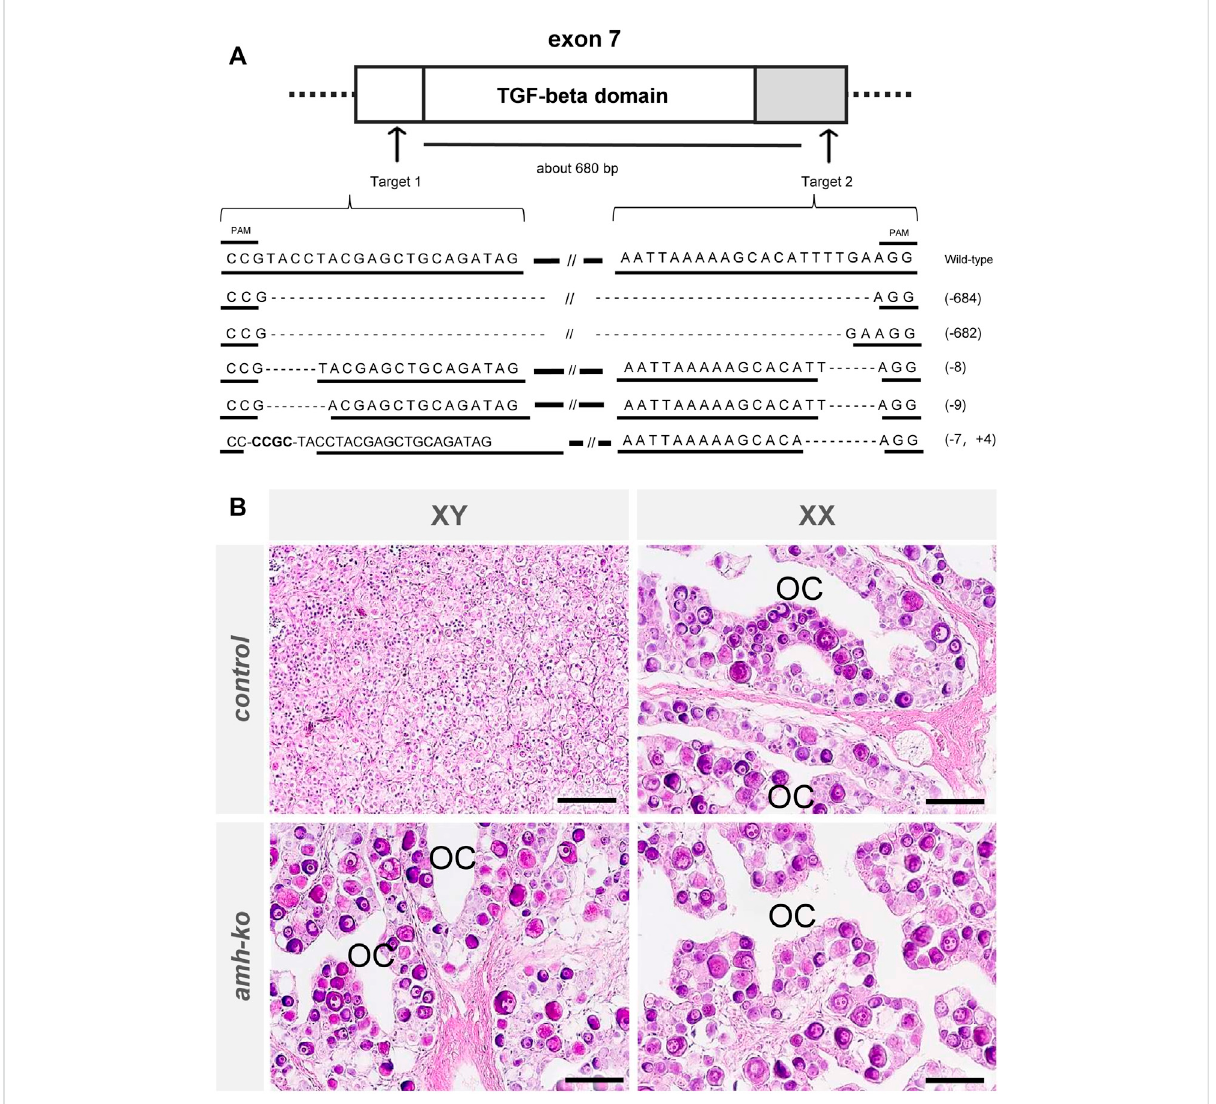
FIGURE 4 Production of amh mutant Japanese fl ounder using CRISPR/Cas9 system. (A) Schematic positions of crRNAs targeted on amh locus, showing exons (white boxes), untranslated regions (gray boxes), introns (horizontal lines) and target sequences of the crRNAs with CRISPR/Cas9 system (arrows). The numbers between target sequences indicate approximate deletion size by CRISPR/Cas9 system. Sequences of wild-type amh and typical mutation of amh mutant with the rate in two target regions. The underlined sequences indicate the two crRNA target sequences. The horizontal lines and dashed line indicate wild-type sequences and deletions, respectively. Slashes indicate omission of long sequences. The number in parentheses indicates the size of deletion (-) or insertion (+). (B) Histological images of gonads in wild-type and amh mutant Japanese fl ounder at 200 days after hatching (dah). In controls, genetic male gonad showed typical testis containing many spermatogonia, and genetic female gonad showedtypicalovaryharboringmanyoocytesandanovariancavity(OC),whichexhibitsmorphologicalcharacteristicsoftheovary.In amh mutants, the genetic male and female gonads showed typically normal ovaries containing many oocytes and an ovarian cavity. Scale bars, 50